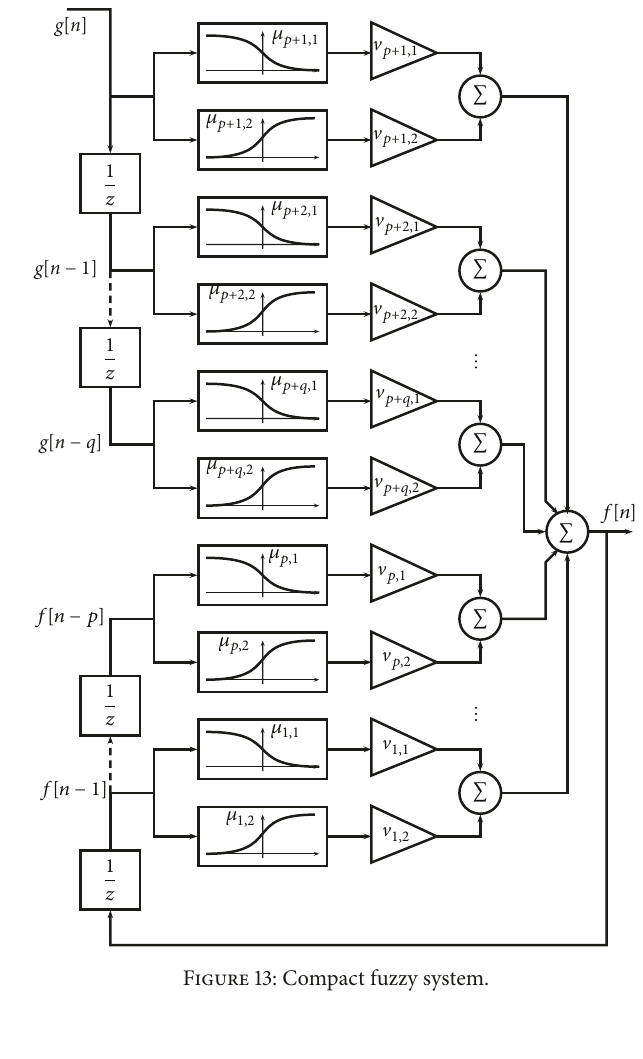
Figure 13: Compact fuzzy system.